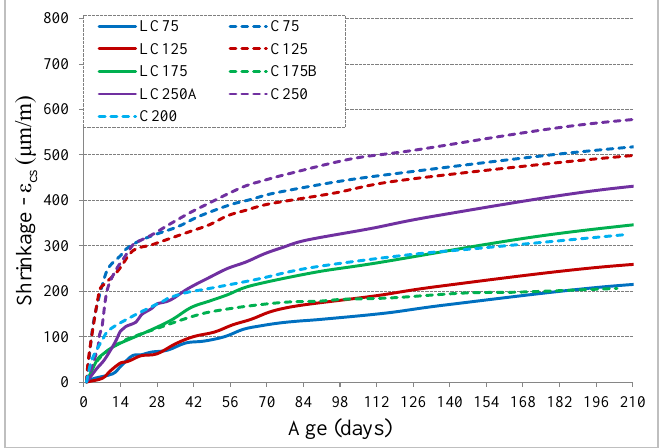
Figure 3. Evolution of total shrinkage with age.